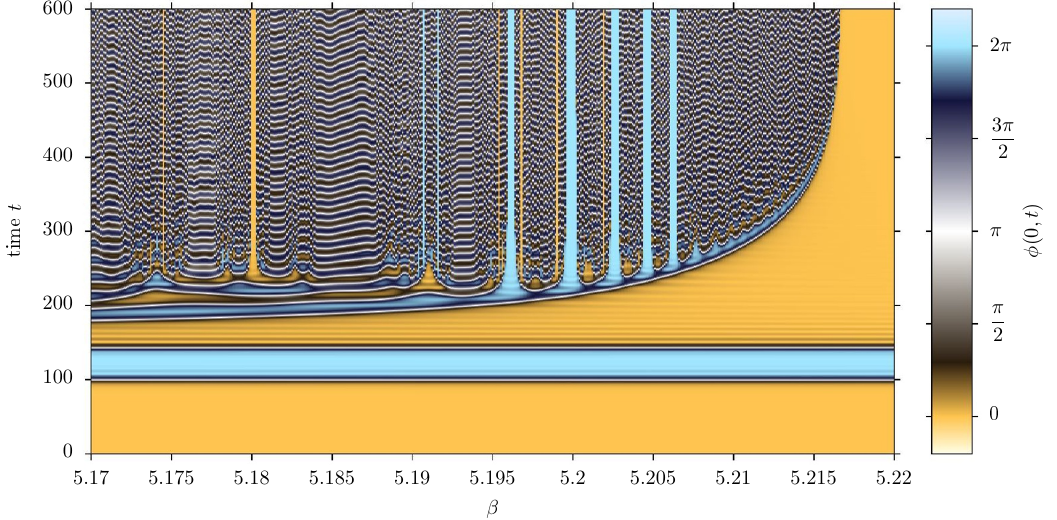
Figure 22 . Field at x = 0 for initial velocity v = 0 . 3 and a range of β cutting into the right-hand edge of the second ‘porcupine spine’ in figure 21, showing both windows and pseudowindows. is produced. A cross-section of the right-hand edge of one of these spines is shown in figure 22. Windows and pseudowindows can be seen corresponding to various numbers of bounces, with a nesting structure which is reminiscent of, but less regular than, the fractal-like patterns seen in regime